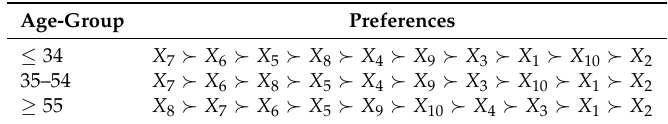
Table 3. Representative preferences attending to different age ranges for Question